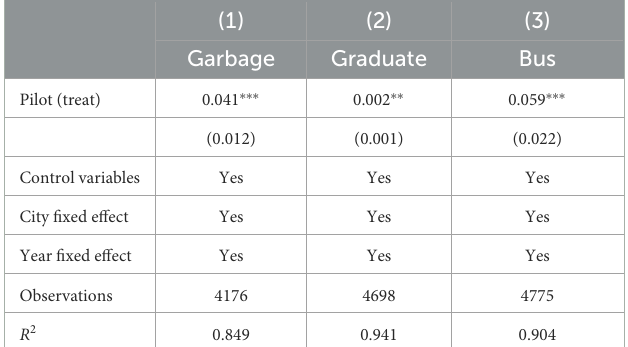
TABLE 5 Mechanism